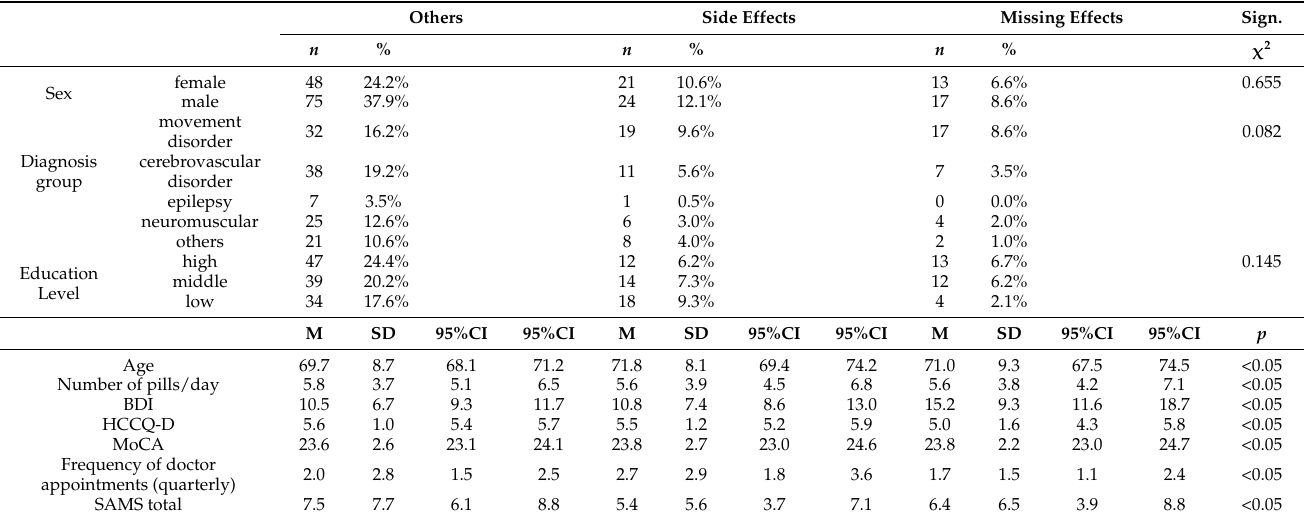
Table 4. Univariate comparison for different reasons of medication change (with Bonferroni